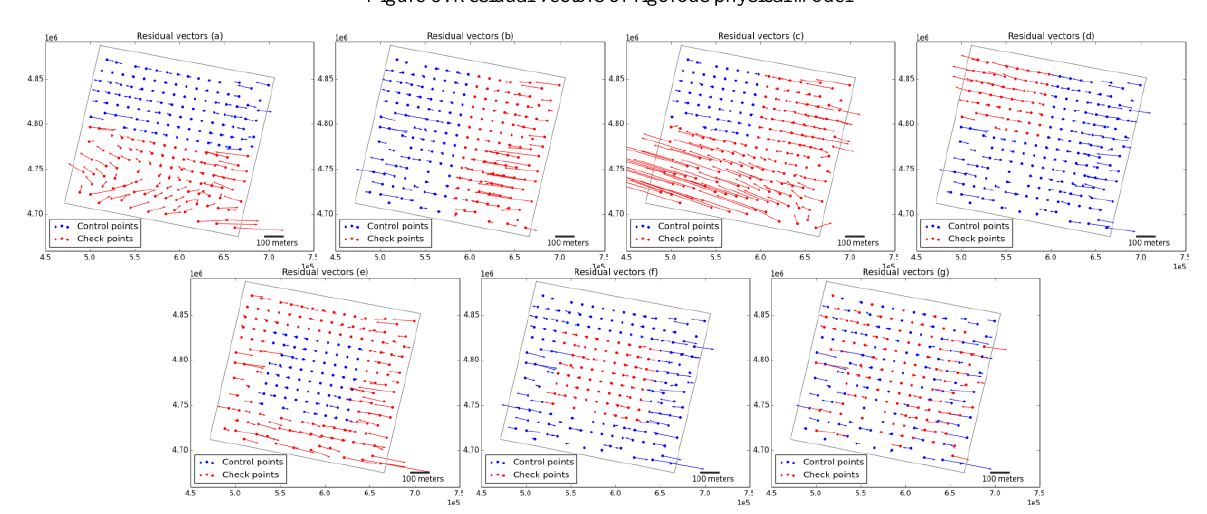
Figure 3. Residual vectors of rigorous physical model